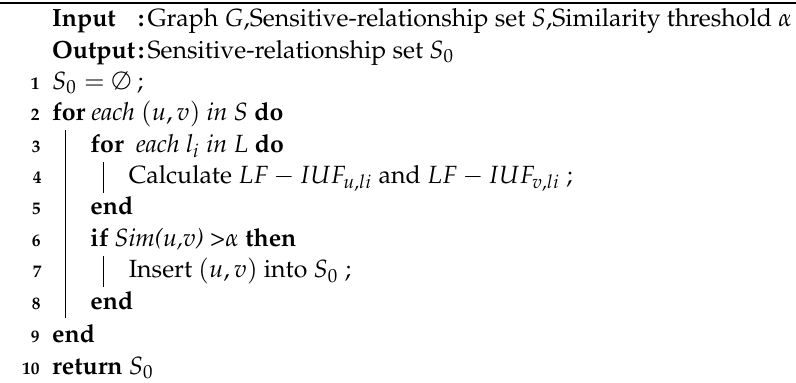
Algorithm 2: Determine Sensitive Data